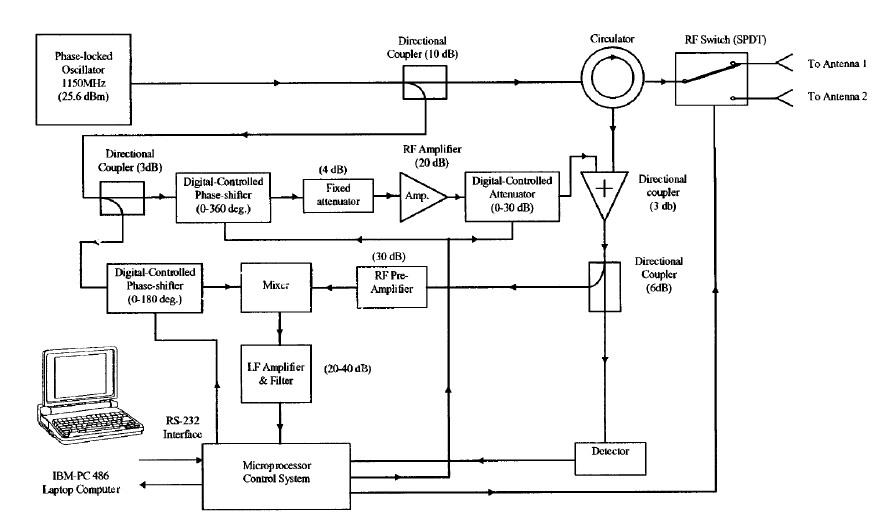
Figure 6. Schematic of the 1.15-GHz microwave radar [82].